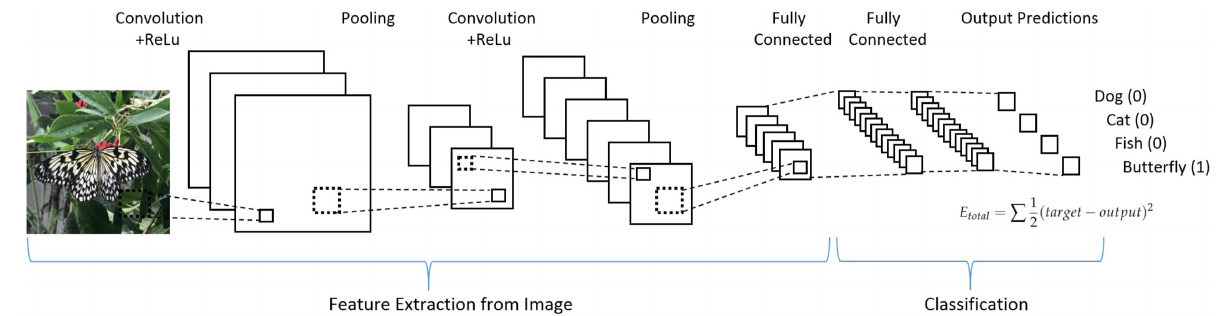
Figure 17. Example of a convolutional neural network. Figure reprinted from Ref. [109] under the terms of CC BY-NC-ND 4.0 license.